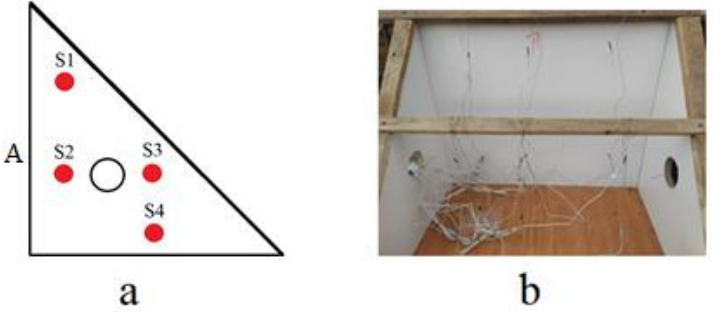
Figure 2. ( a ) Layout of temperature sensors; ( b ) installed temperature sensors inside the model